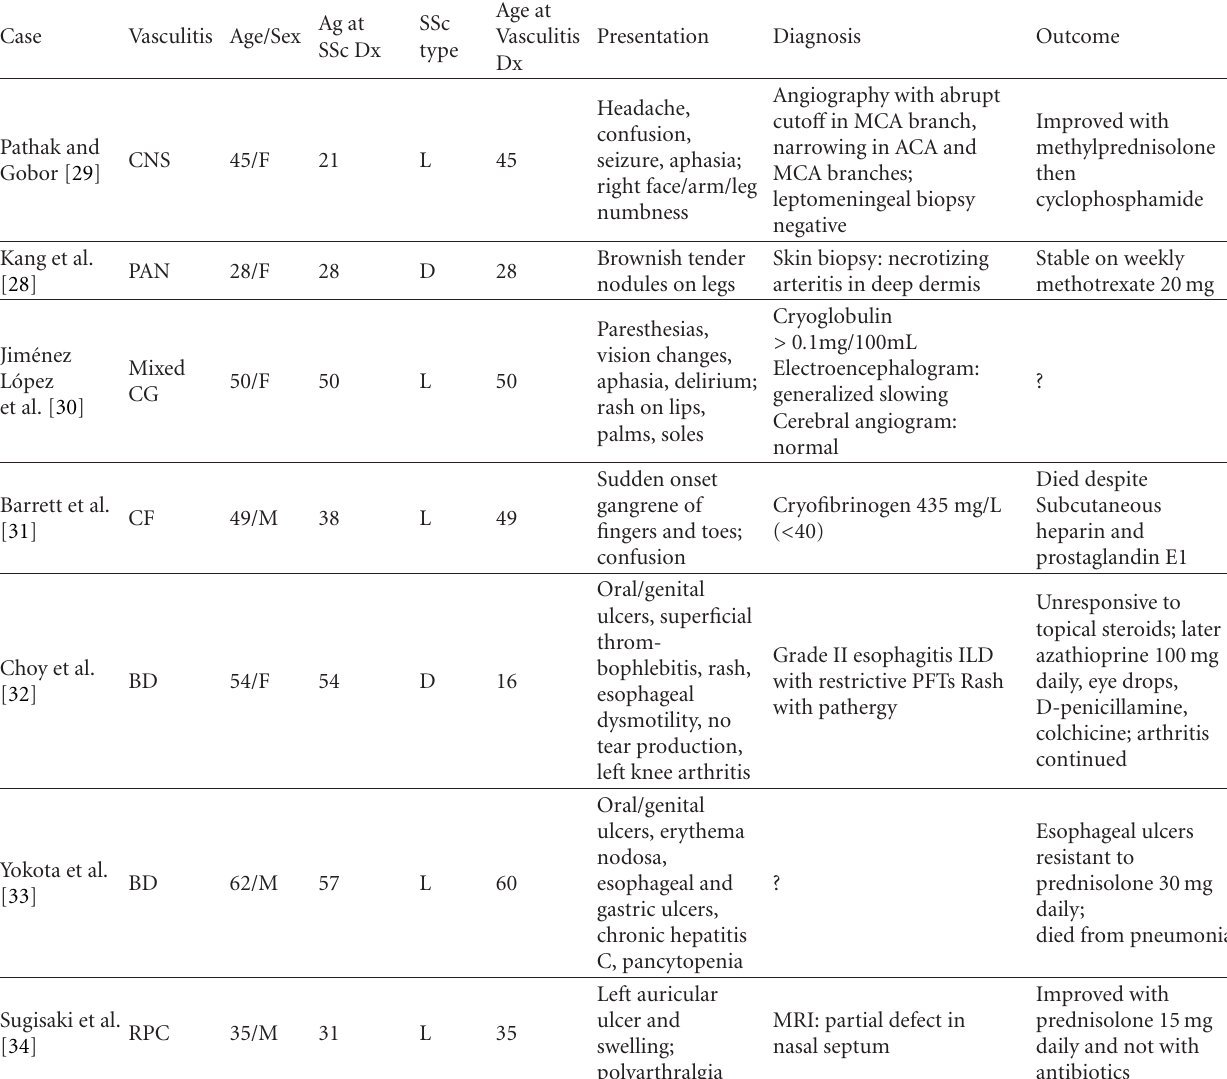
Table 2: Seven cases of medium- and-small vessel vasculitis associated with